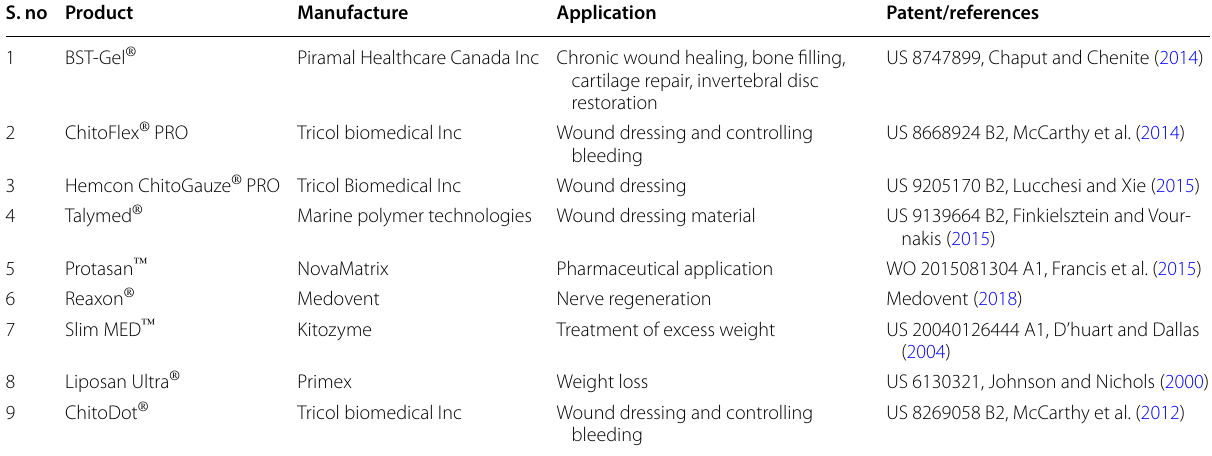
Table 6 Chitin‑based commercial products and their applications S. no